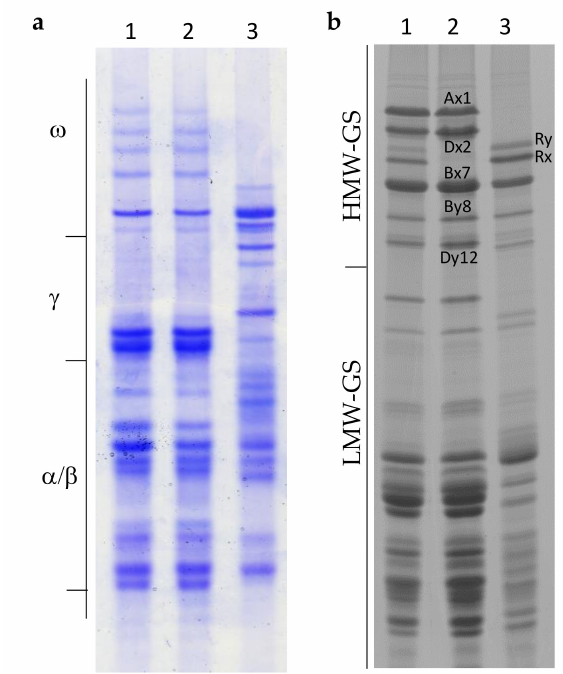
Figure 1. Comparison of gliadin ( a ) and glutenin ( b ) composition of N11, N11 XY7 , and XY7: ( a ) Acid polyacrylamide gel electrophoresis (A-PAGE) separation of gliadins, ( b ) SDS-PAGE separation of glutenins. Lane 1, N11 XY7 ; lane 2, N11; lane 3,